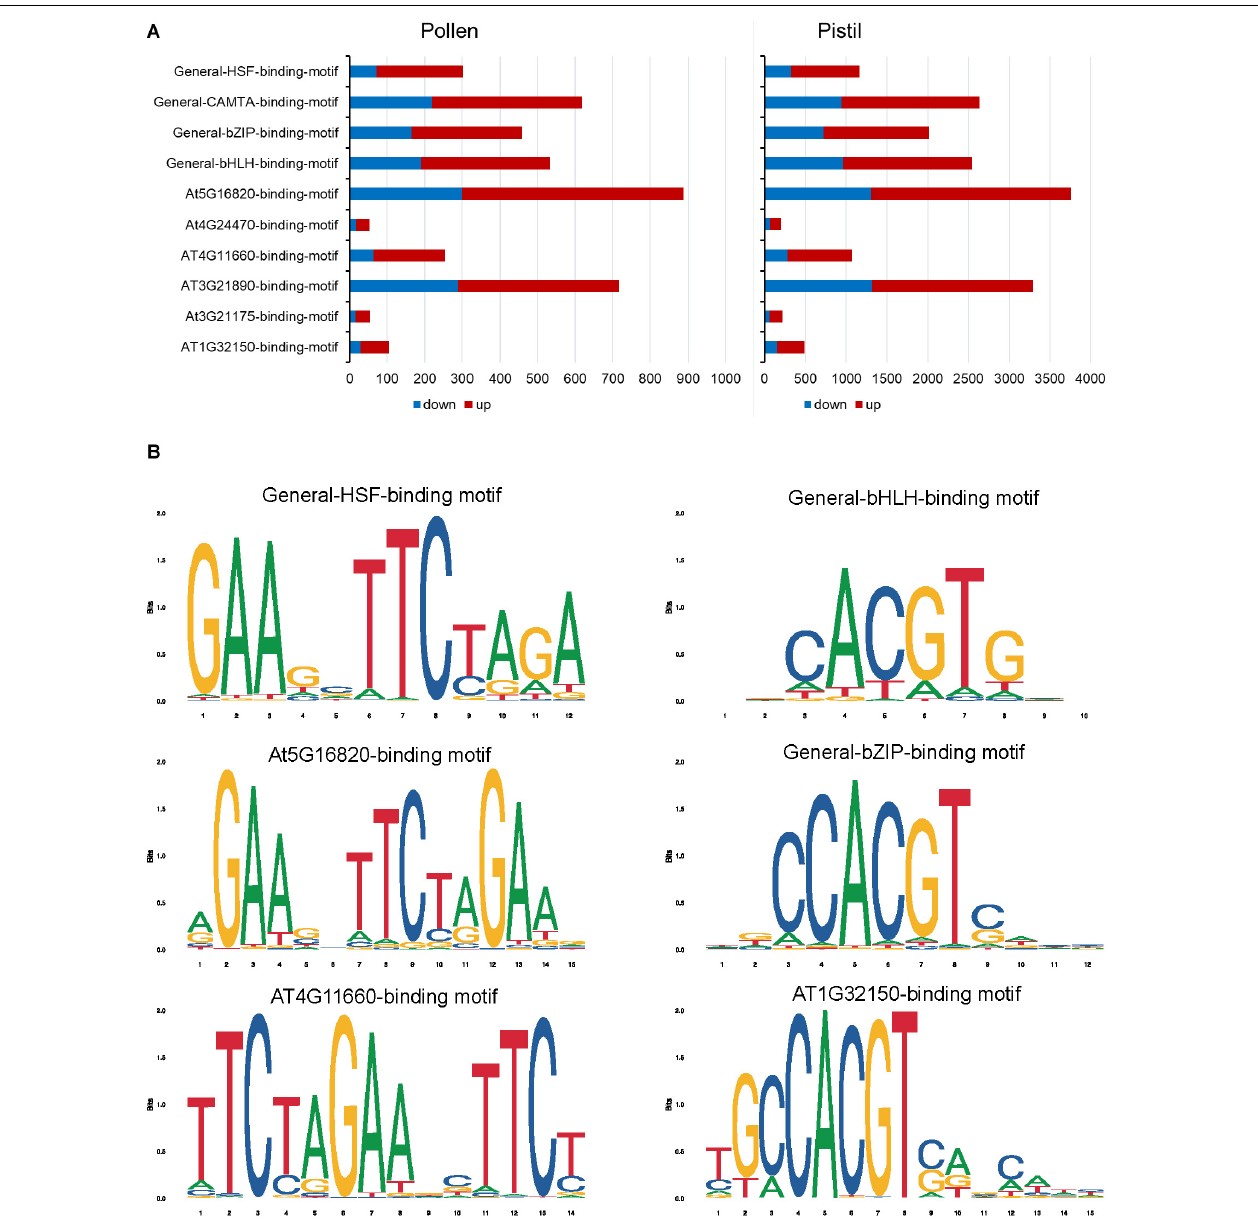
FIGURE 11 | Heat stress-responsive transcription factor binding sites present in the 1 kb promoter region of the differentially regulated genes in heat-stressed pollen and pistil. (A) Top significantly enriched of DEGs in heat-stressed pollen and pistil. (B) Consensus sequence of HSF (General-HSF-binding-motif, At5g16820-binding-motif, At4G11660-binding-motif), bHLH and bZIP (General-bZIP-binding-motif, At1G32150-binding-motif) transcription factor binding